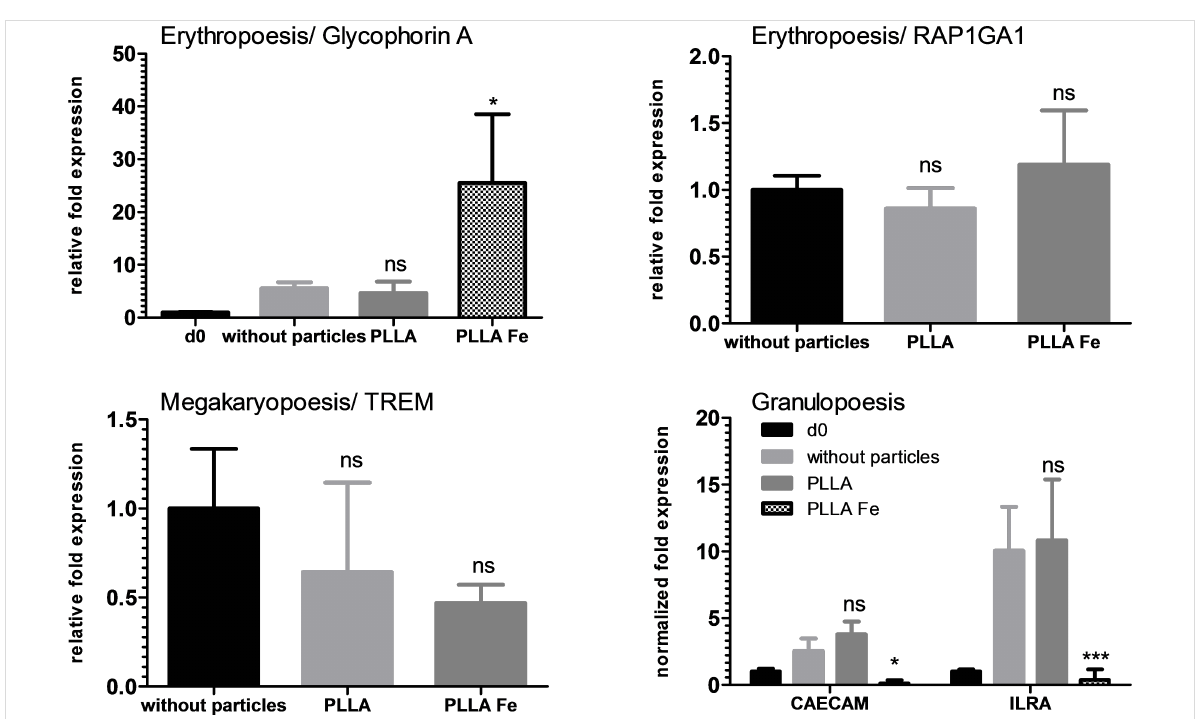
Figure 9: qPCR results of the polylactide particles in hHSCs. For glycophorin A, a significant increase could be detected when PLLA–Fe particles were used. On the other hand, the granulocytic markers CAECAM and ILRA were suppressed with PLLA–Fe